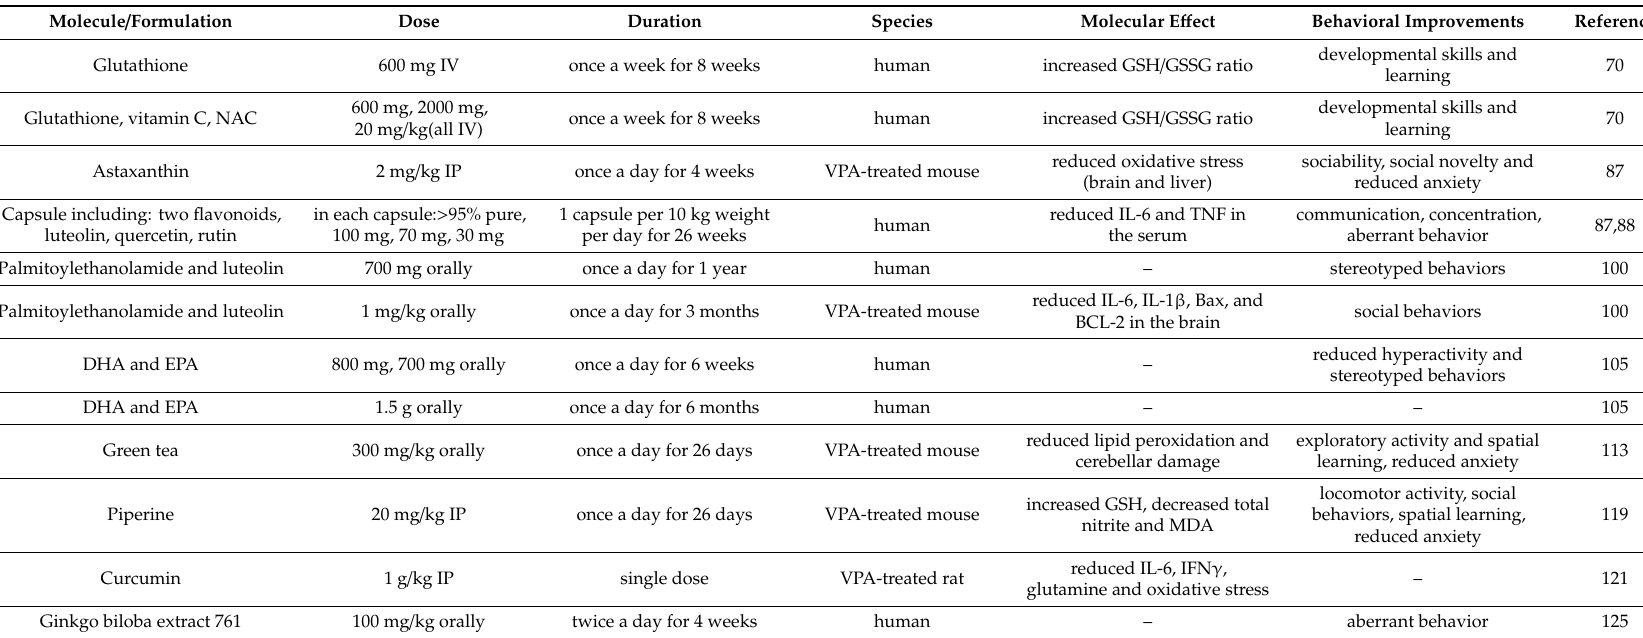
Table 1. Summary of the studies describing the effects of natural antioxidants on autism spectrum disorder (ASD) animal models and humans with ASD. Dose, duration of the treatment, species, molecular effects, and behavioral improvements are reported in the table. IV: intravenously; IP: intraperitoneally; VPA: valproic